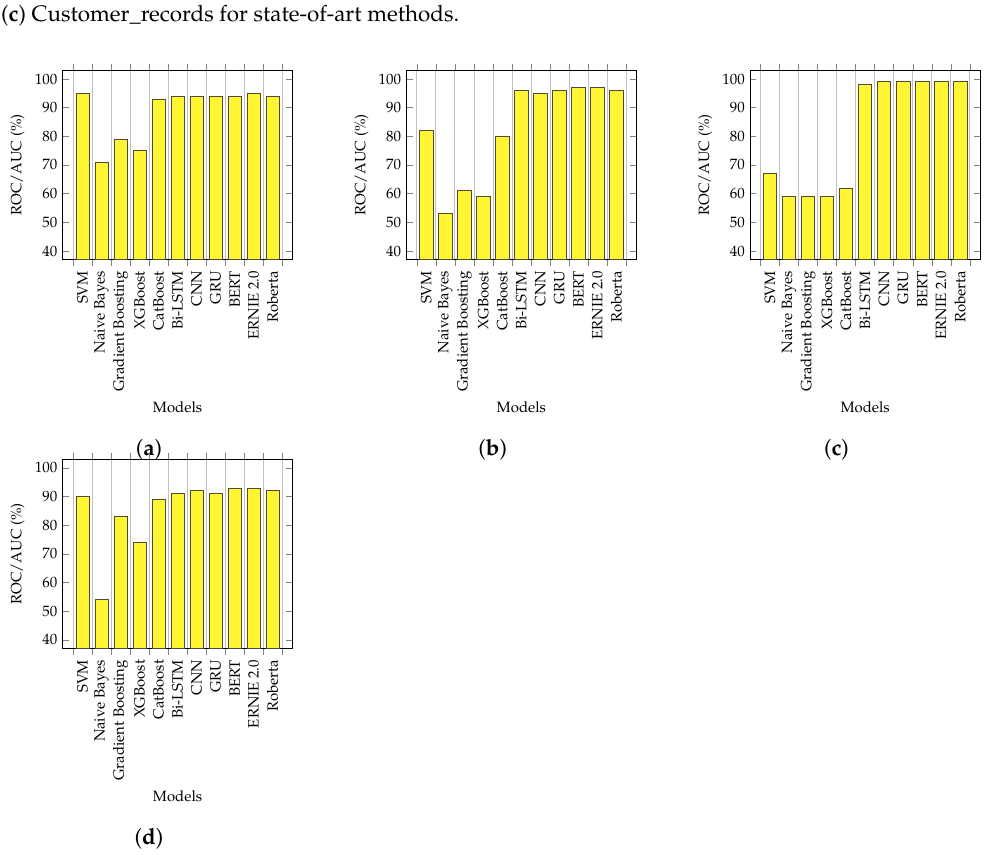
Figure 8. Quantitative ROC/AUC results across ( a ) Agency_resampled, ( b ) Employee_resampled ( c ) Customer_resampled, and ( d ) Combine_All for state-of-art methods. We also experimented with our synthetic data curation (SMOTE). For the Agency_smote and the Employee_smote, XGBoost performed best with 94% and 86% ROC scores, re- spectively. GB performed best for the Customer_smote with an 85% ROC value. Figure